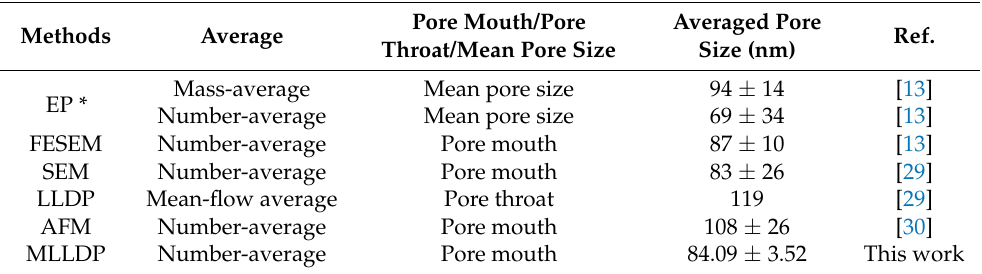
Table 5. Comparison of PSD (pore size distribution) measurements of nominal 100 nm Anopore TM membrane with different